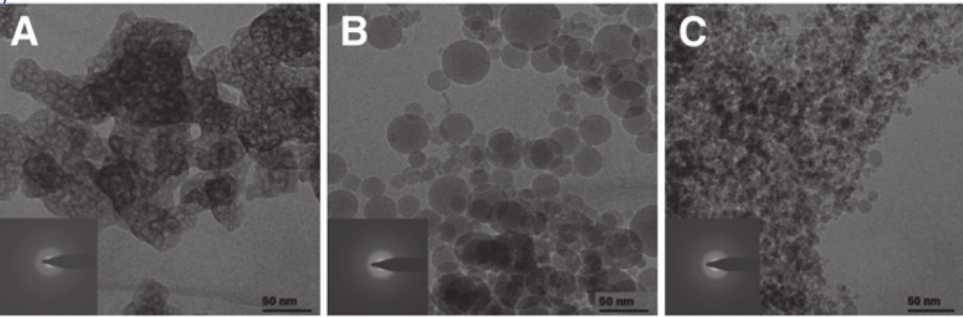
Fig. 1 Transmission electron microscope (TEM) images of commercial (a: SSA = 33 m 2 /g) and FSP-made (b,c: 69 and 195 m 2 /g, respectively) FePO ticles were dense and spherical, while the commercial ones exhibited an irregular and highly porous structure. The particle size calculated from specific surface area measurements cor- responds to 11 nm for the small, FSP-made particles (c). The SAED (selected area electron diffraction) patterns in the insets are characteristic of an amorphous substance for all three compounds 39)